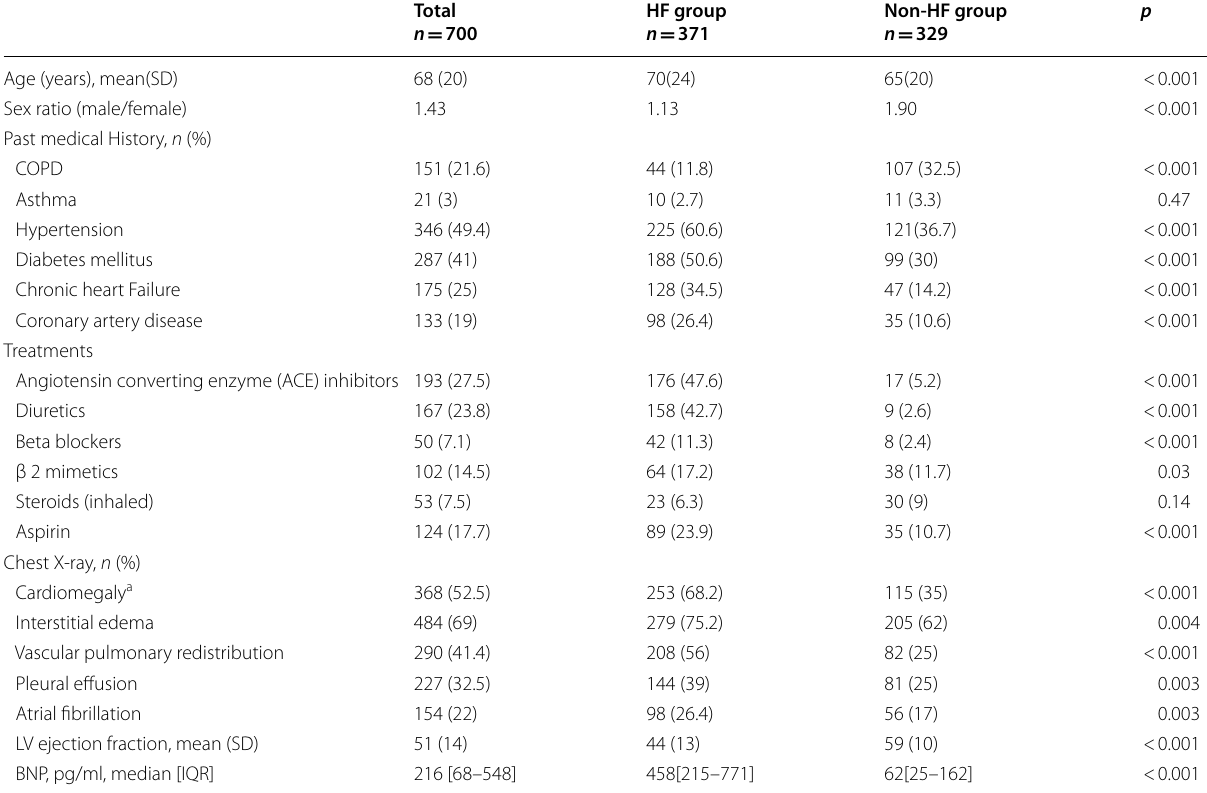
Table 1 Characteristics of study population